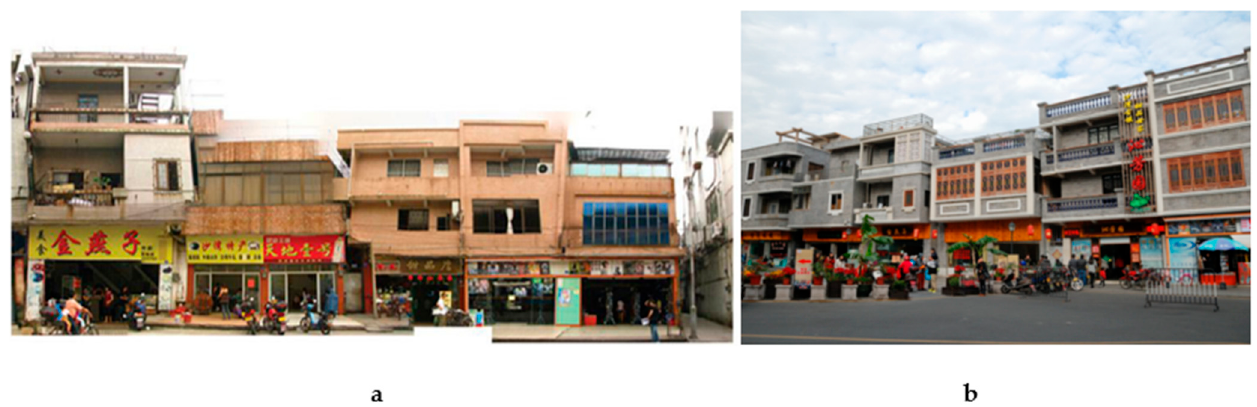
Figure 13. Renovation of Daxiangyong Road (Source: [31]) ( a ). Part of the east side of Daxiang Chong (before reconstruction) ( b ). Part of the east side of Daxiang Chong (after reconstruction).